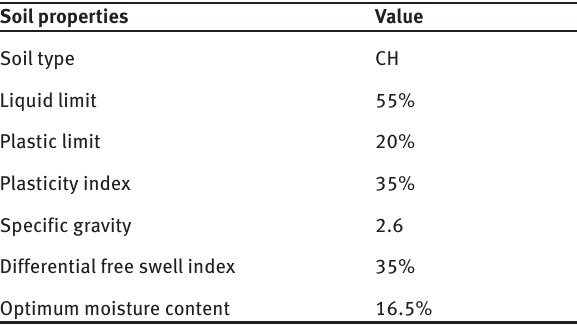
Table 4: Chemical properties of molasses used.